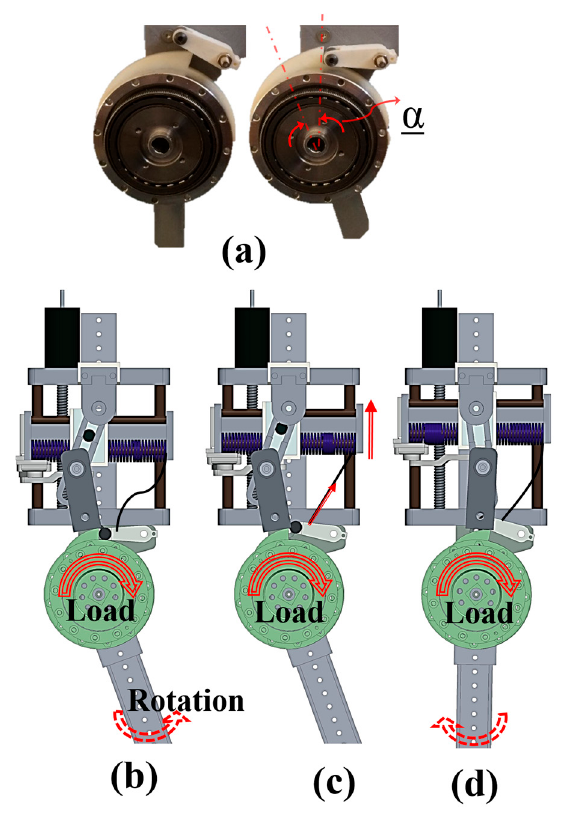
Figure 4. The ARES-XL locking mechanism: ( a ) prototype: tooth— RT and pawl- L1 default deflection to engage; ( b ) pawl- L1 is engaged and locks the deflection; ( c ) pawl is disengaged by adjusting L 2 position; ( d ) free-swing, locking disengaged.